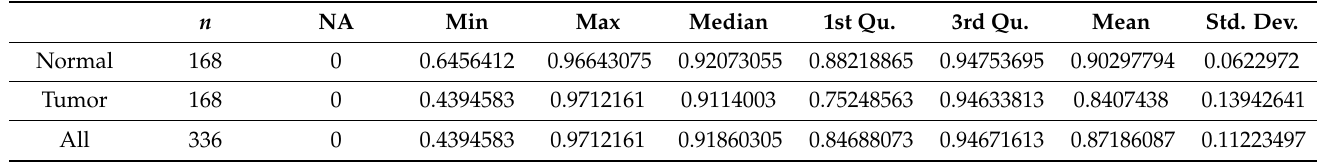
Table 3. KIRC β -values and statistics.